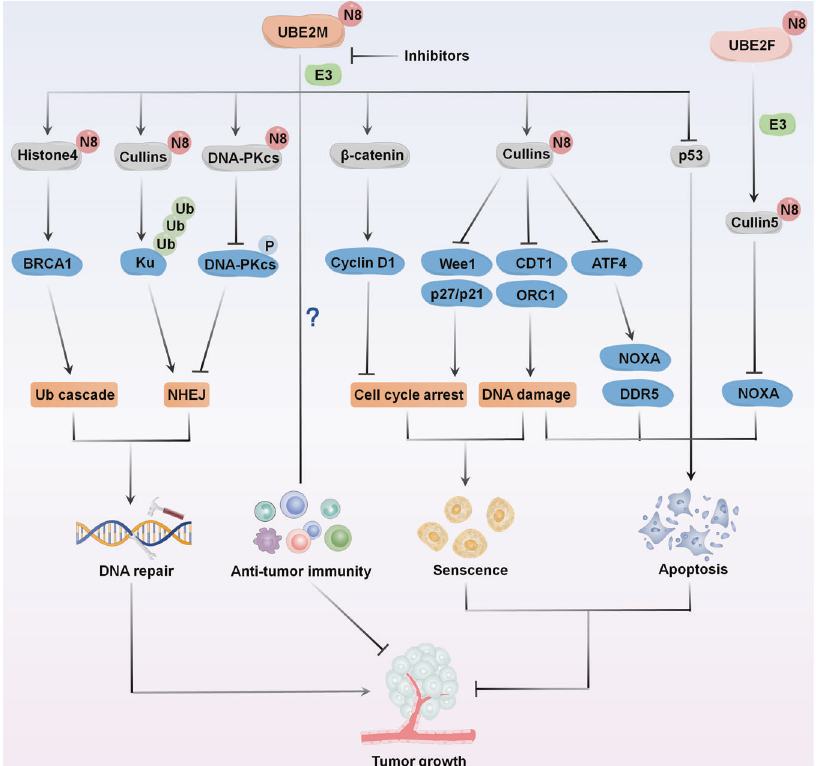
Fig. 4 The function of UBE2M and UBE2F in tumor growth. UBE2M in fl uences tumor growth by modulating several biological responses of tumor cells, such as DNA-damage response, cell cycle arrest, apoptosis, or senescence. UBE2F promotes the degradation of NOXA and then inhibits apoptosis and induces tumor